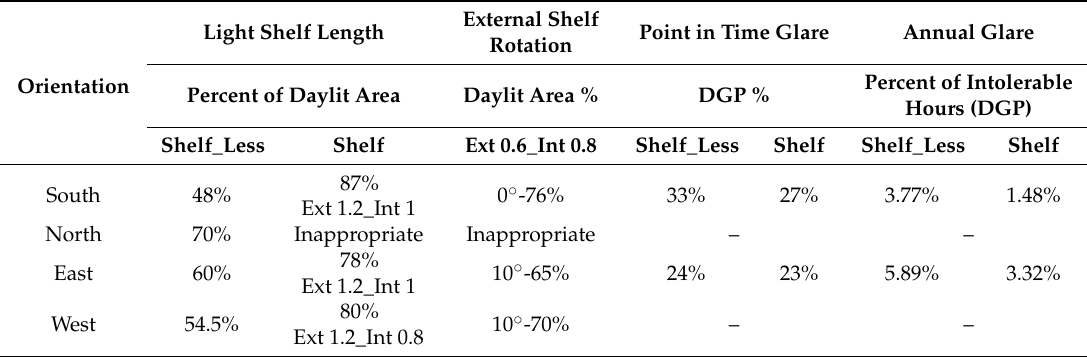
Table 4. Summary results of the light shelf